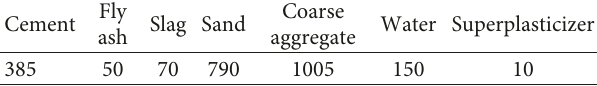
Table 1: Mix proportions of concrete (kg/m 3 ).